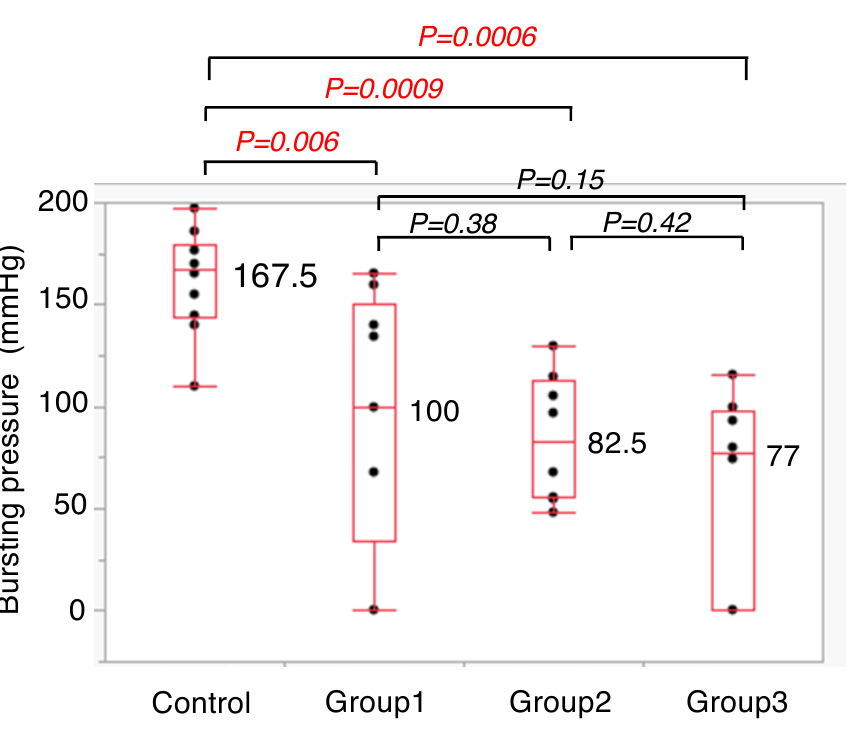
Figure 5. Bursting Pressure on POD 5.